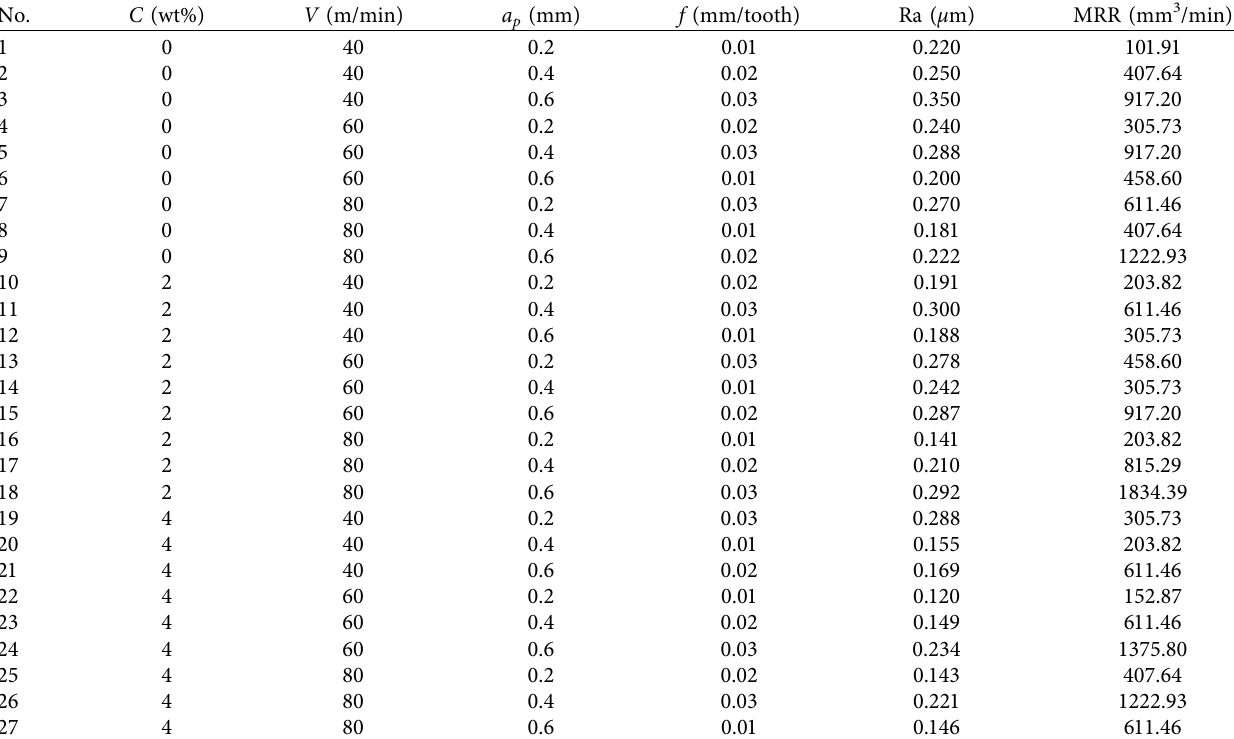
Table 4: Result of roughness and material removal rate.